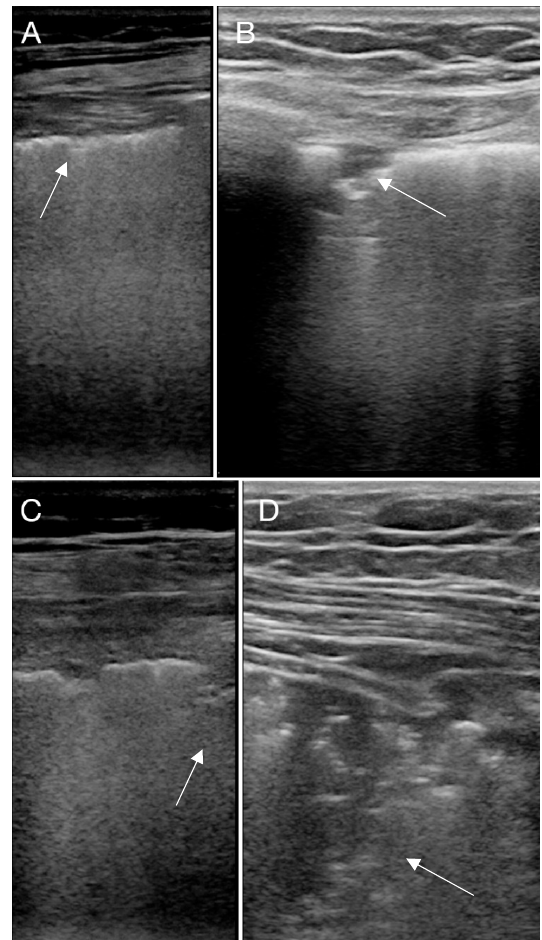
Figure 2. An irregular pleural line is observed in ( A ) (marked with an arrow). In ( B ) and ( C ) small subpleural consolidations are found (marked with an arrow), while in ( D ), a larger subpleural consolidation with air-bronchogram is found (marked with an arrow).